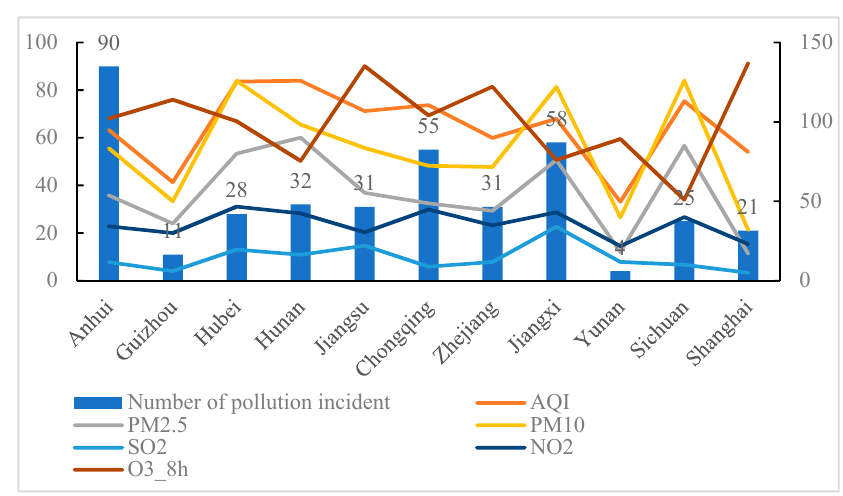
Figure 2. Number of pollution incidents and monitoring data in the Yangtze River Basin (YRB).